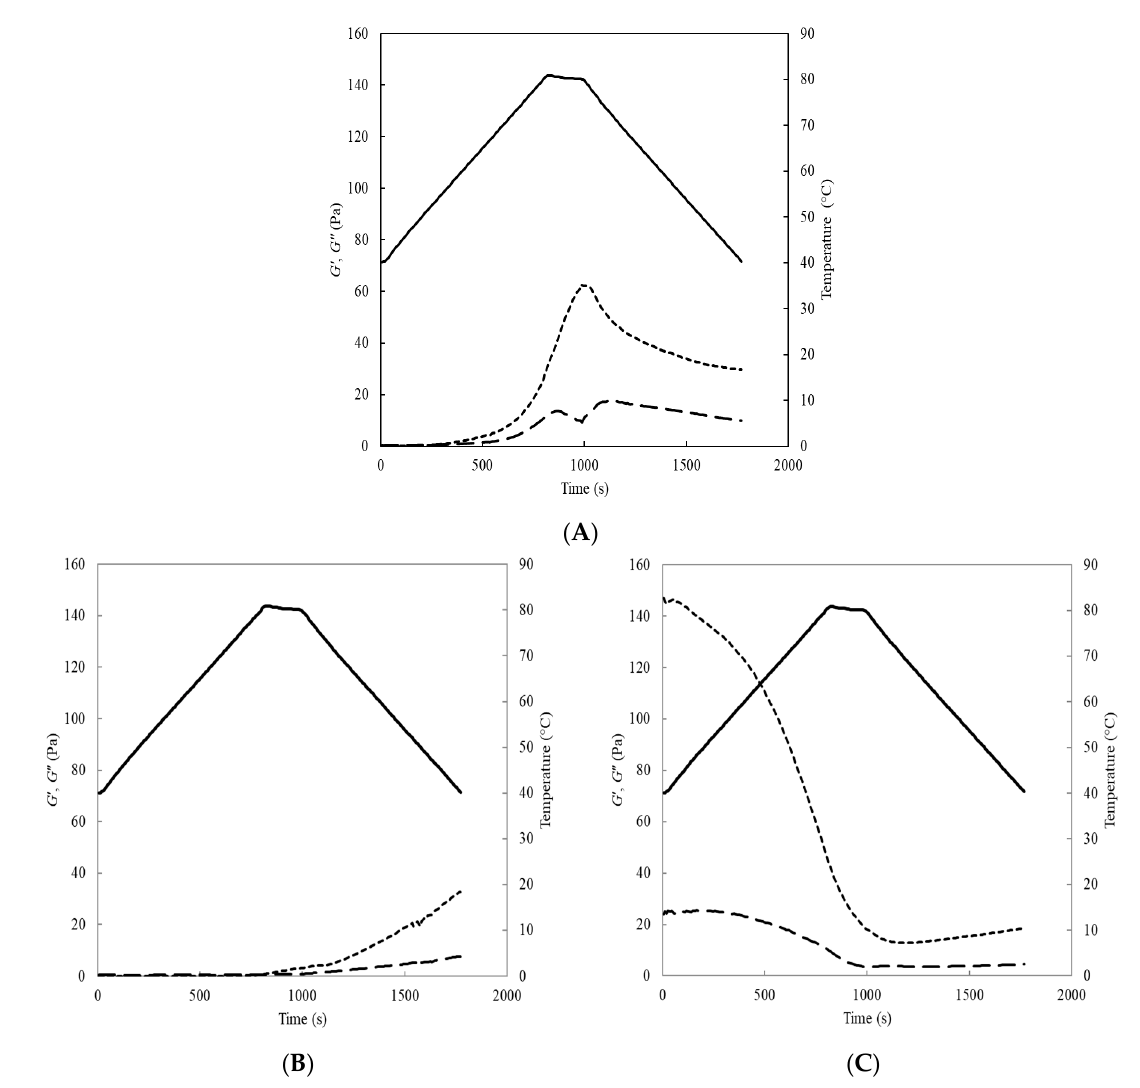
Figure 6. Elastic ( G ′ ; ---- ) and viscous ( G ″ ; ─ ─ ) modulus of soy protein isolate dispersions (10%, w/w ) measured at pH 2.0 ( A ), pH 6.9 ( B ) and pH 9.0 ( C ), as a function of temperature ( ― ).